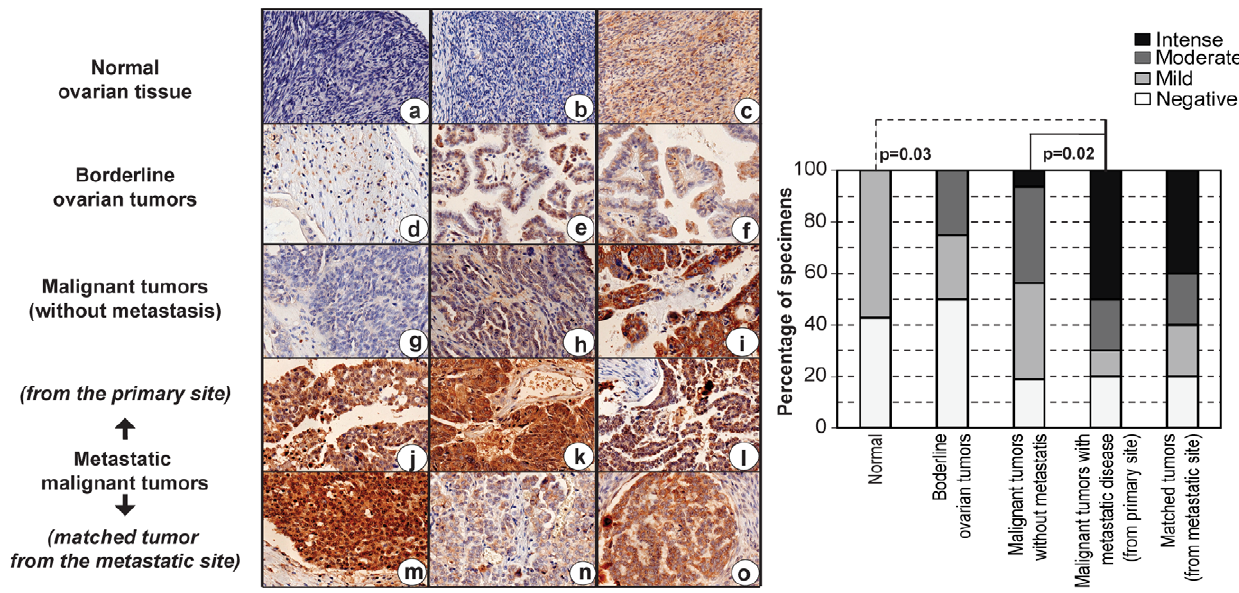
Figure 7. 14-3-3 s expression and ovarian tumor metastasis. Immunohistochemical analysis of 14-3-3 s in ovarian tissues show negative (hematoxylin stained blue nucleus) to diffuse staining pattern for 14-3-3 s (brown) in normal ovarian tissues (a–c), and a moderate increase in the staining intensity localized to the cytoplasm is observed in the borderline ovarian tumors (d–f). In the malignant tumors without any metastatic disease at diagnosis, 14-3-3 s expression was either absent (g), or stained at moderate to intense levels (h–i), with occasional nuclear staining (i). Intense nuclear and cytoplasmic staining for 14-3-3 s was observed in ovarian tumors with metastatic disease, obtained from the primary site of the disease, and a moderate to intense staining for 14-3-3 s in the cytoplasm or both nucleus and cytoplasm of the corresponding tumors obtained from the metastatic site was observed [site of metastasis - (m) appendix, (n) lymph node and (o) omentum]. The quantitative relationship between 14-3-3 s expression and various stages of ovarian cancer progression is represented in the bar graph, and the statistical analysis for correlation of expression with pathological grades were determined by a Fisher’s exact test.